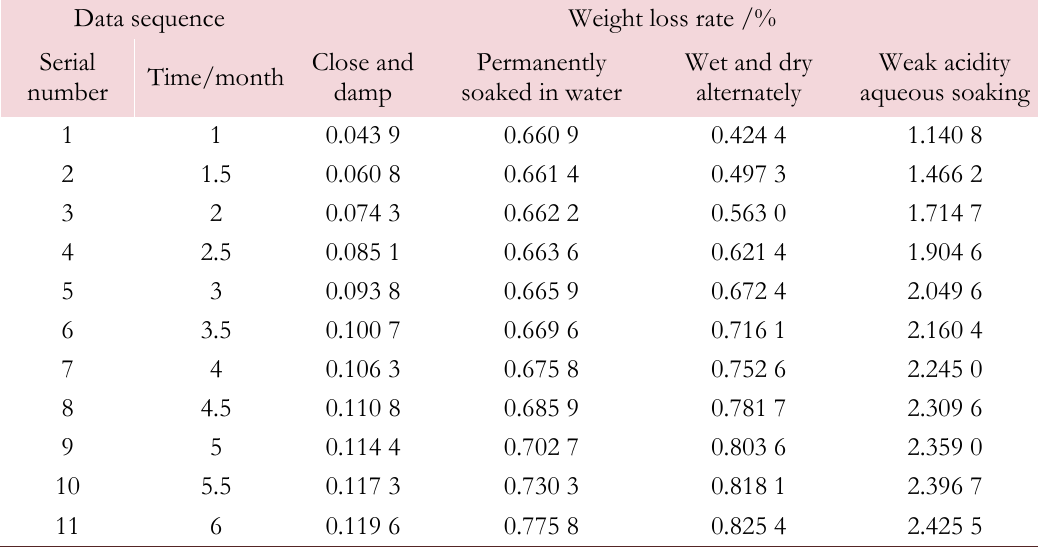
Table 2: Data sequences modeled by GM (1,1).